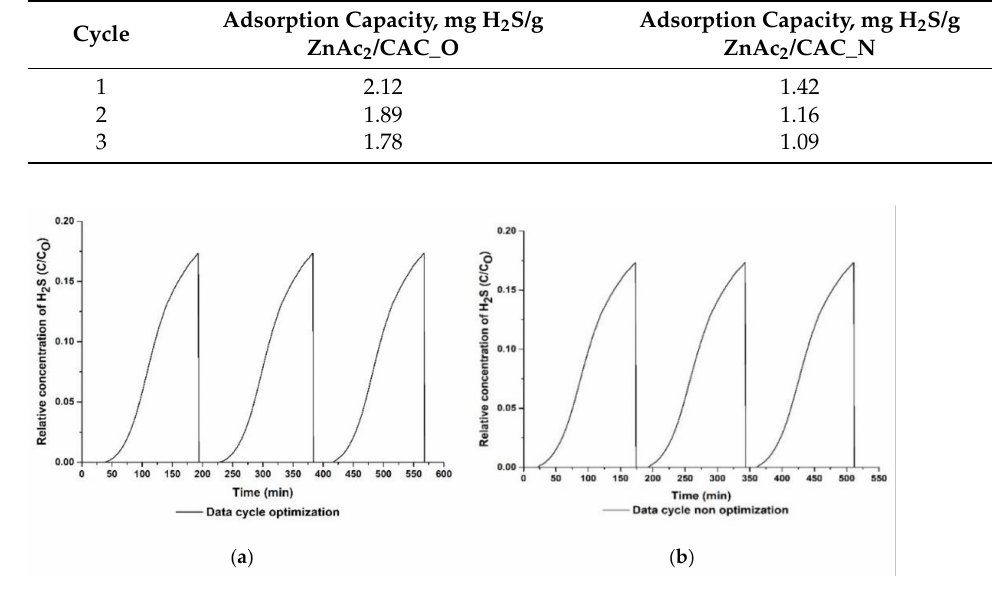
Figure 12. Regeneration adsorption–desorption curve for ( a ) optimized adsorbent and ( b ) non- optimized